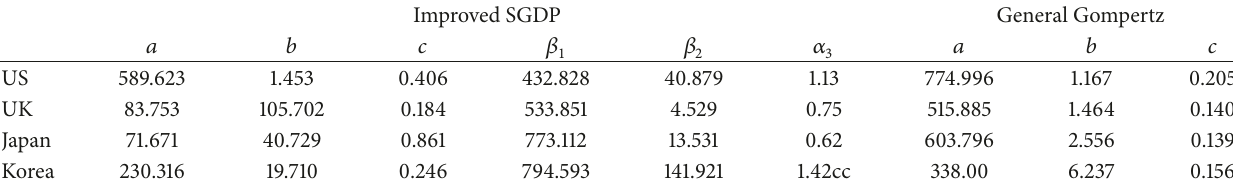
Table 1: Estimated parameters of improved SGDP and general Gompertz in sample countries.